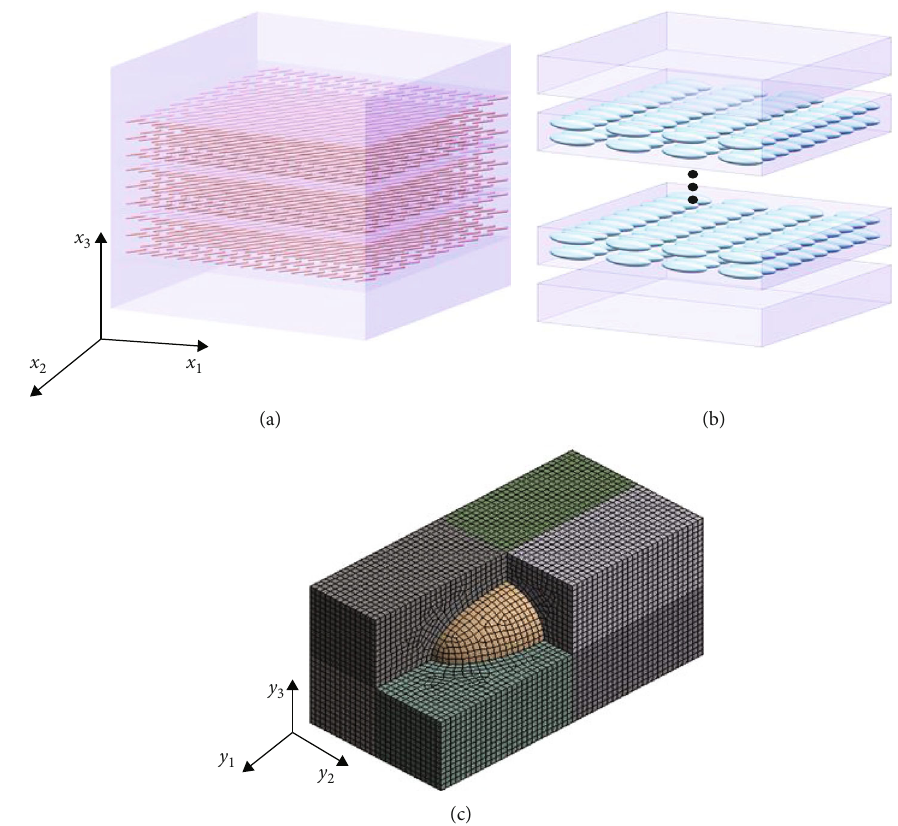
Figure 2: Simpli fi ed modeling procedure of the SMPC reinforced with natural short fi bers. (a) The e ff ective 3D equivalent structure. (b) SMPC treated as the composite laminated reinforced with the periodic ellipsoidal inclusion. (c) The RVE discretized by serials of hexahedral